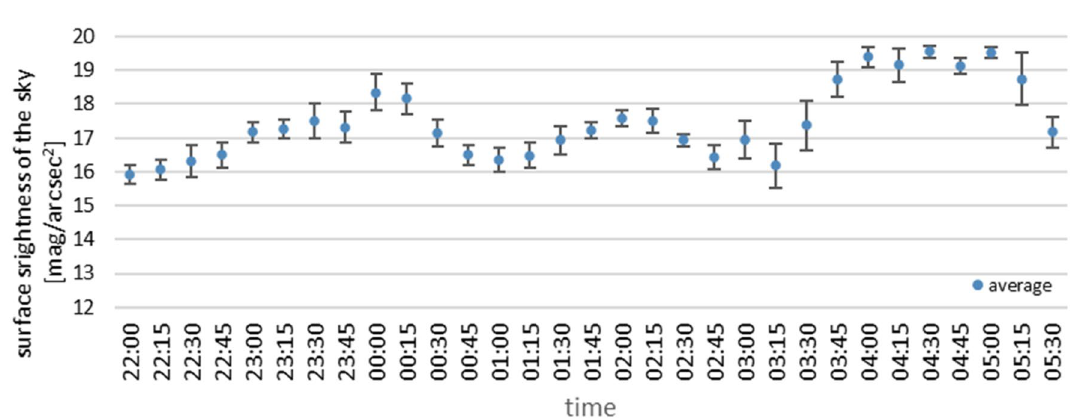
Figure 11. Summary of measurements from all devices during the night with variable cloudiness of December 24 to 25,